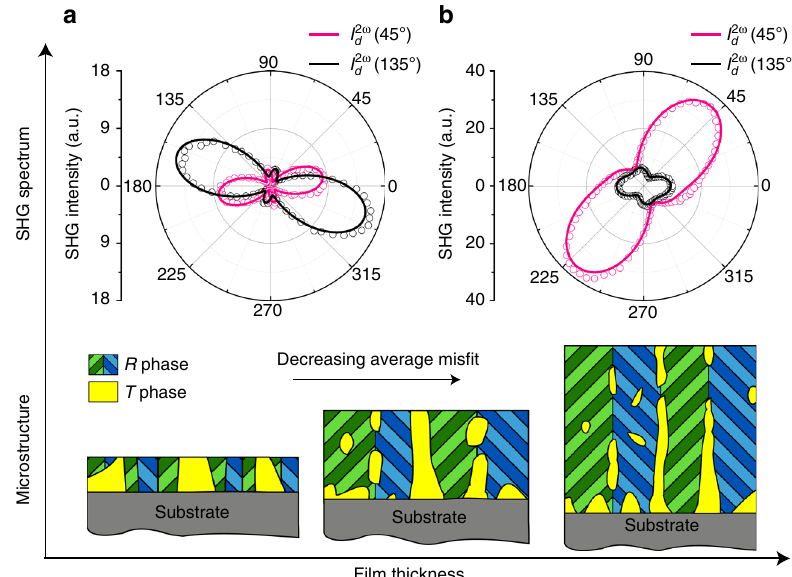
Fig. 3 Schematic of the microstructure evolution with fi lm thickness. a , b are intensity pro fi les of the transmitted d -polarized SHG signals from a 350-nm and a 1.8- µ m-thick BZT fi lm,